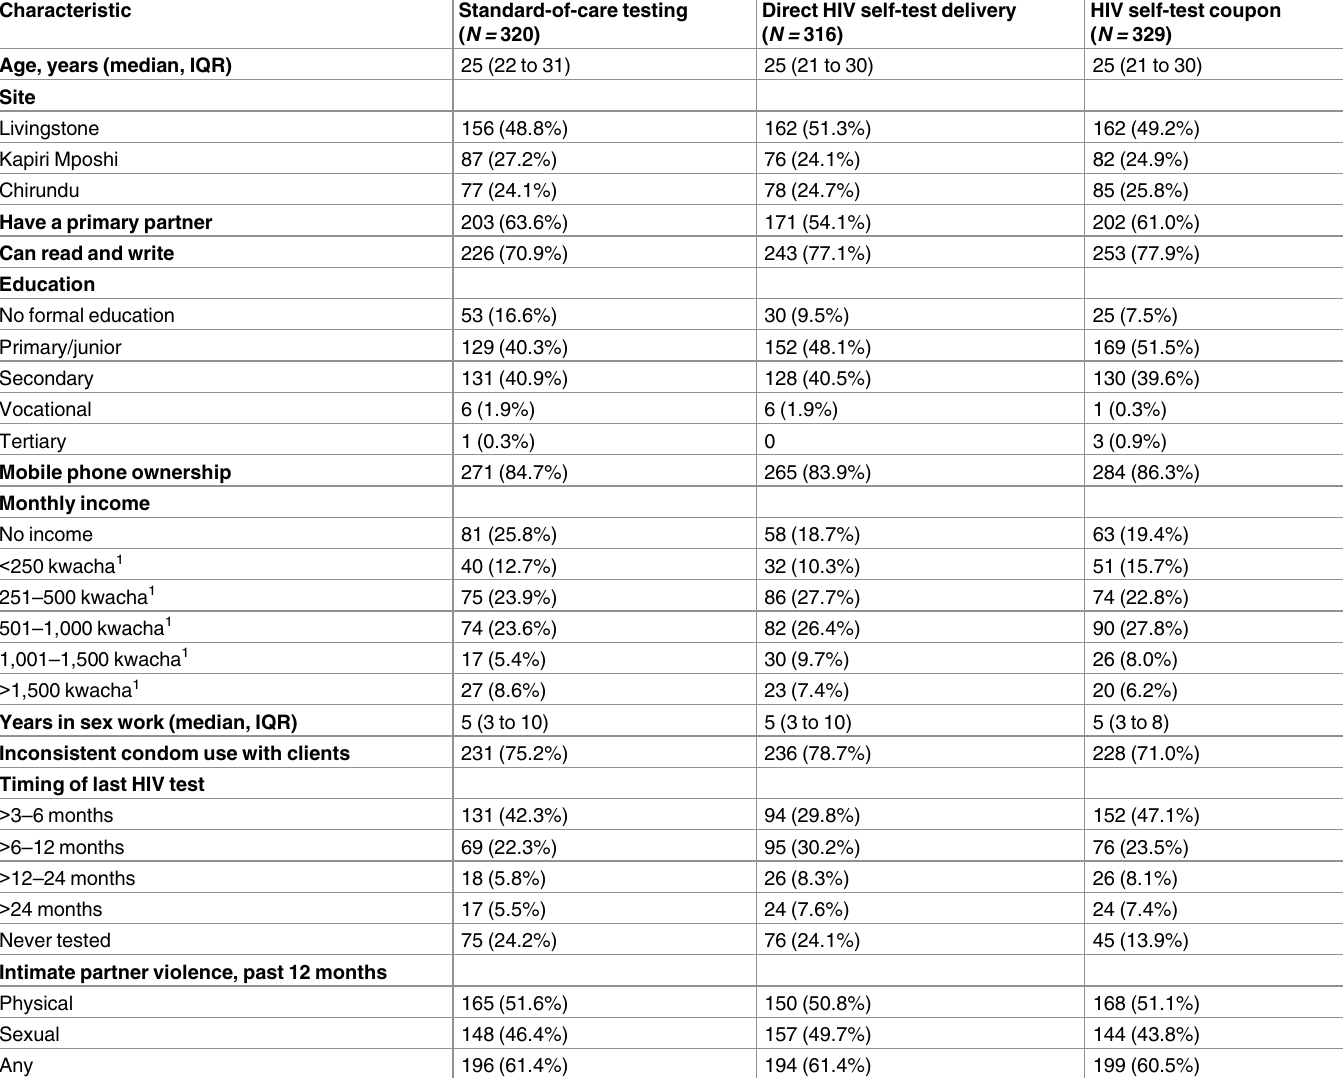
Table 1. Baseline descriptive characteristics by randomization